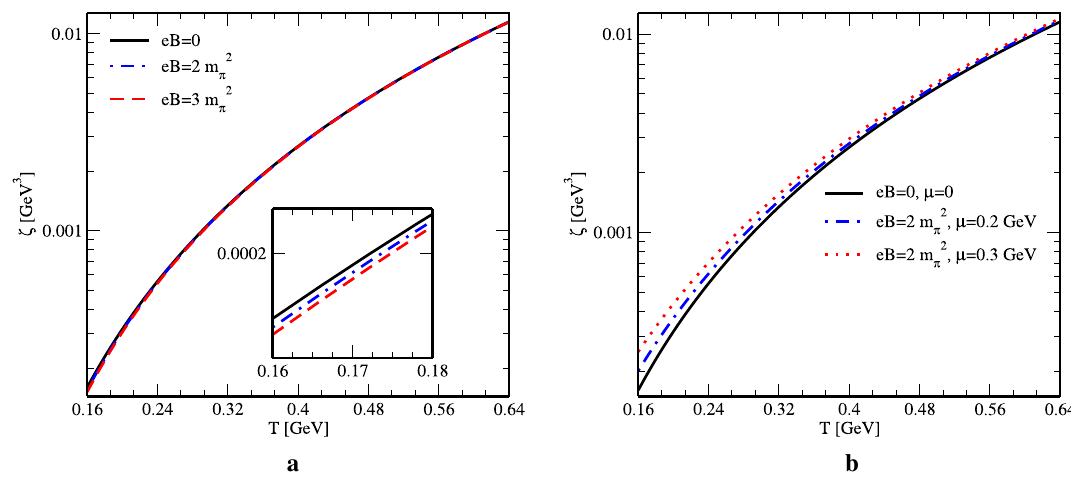
Fig. 2 The variation of the bulk viscosity with temperature ( a ) in the presence of weak magnetic field and ( b ) in the presence of finite chemical potential